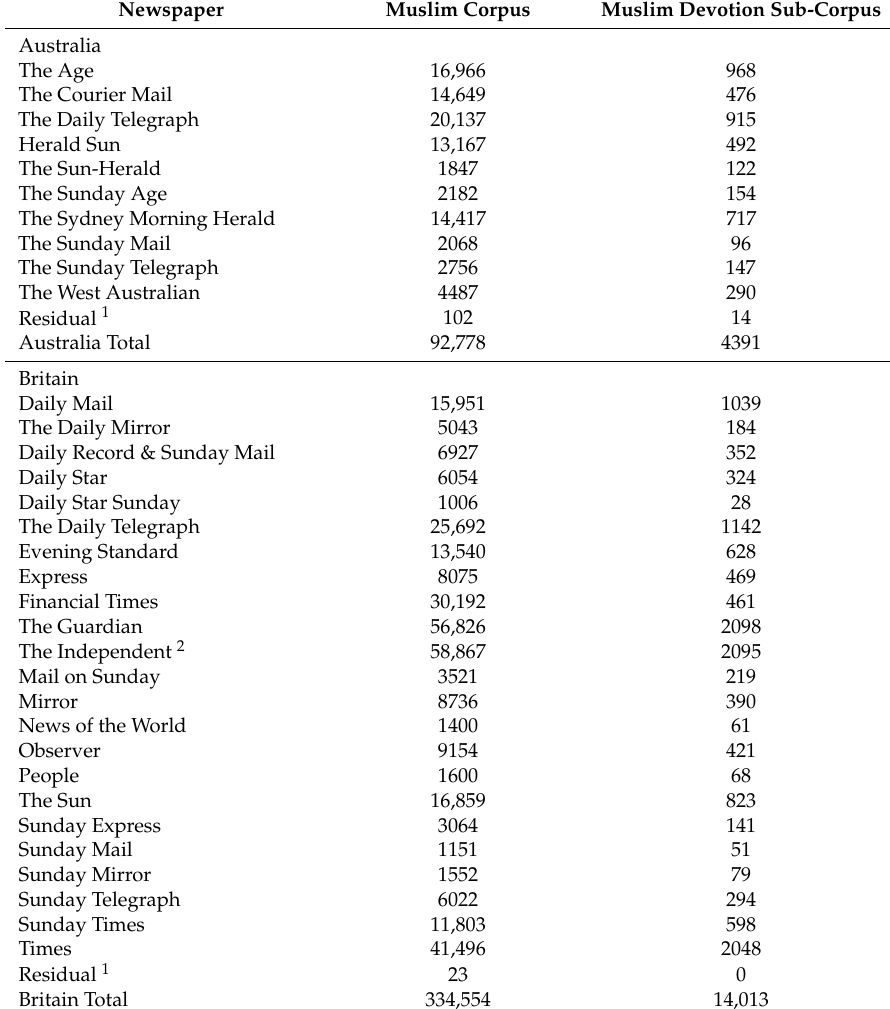
Table A1. Articles Included in Our Corpora, by